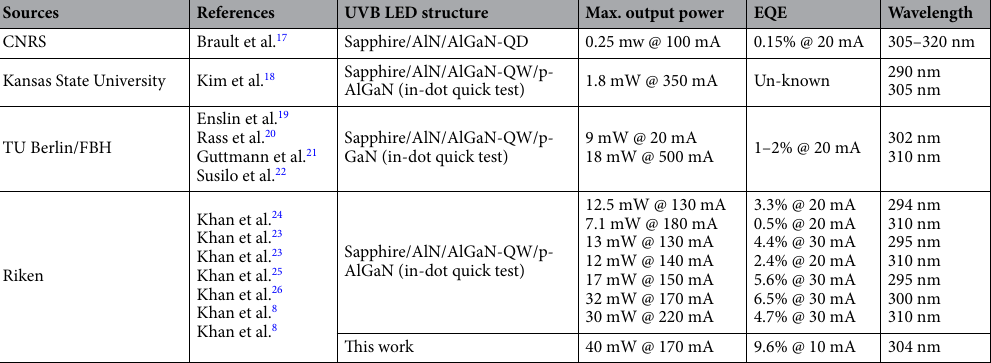
Table 1. A comparison of the performances of AlGaN/p-GaN ultraviolet-B (UVB) light-emitting diode architectures grown on AlN template on the c-sapphire substrate, as well as their reported efficiencies and light output powers of selected next-generation UVB devices at room temperature (RT). The listed UVB light- emitting diode devices show slight variations in device design, performance, and measurement